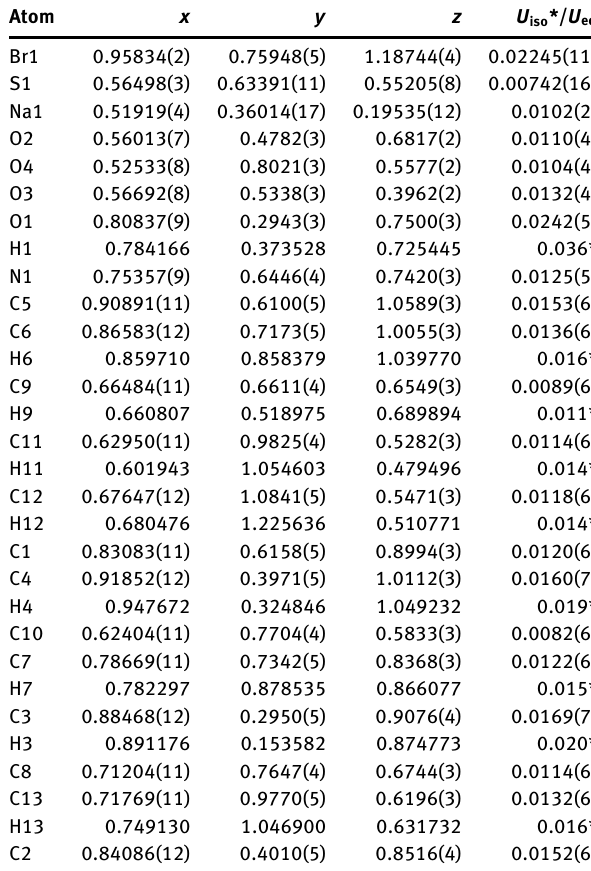
Table 2: Fractional atomic coordinates and isotropic or equivalent isotropic displacement parameters (Å 2